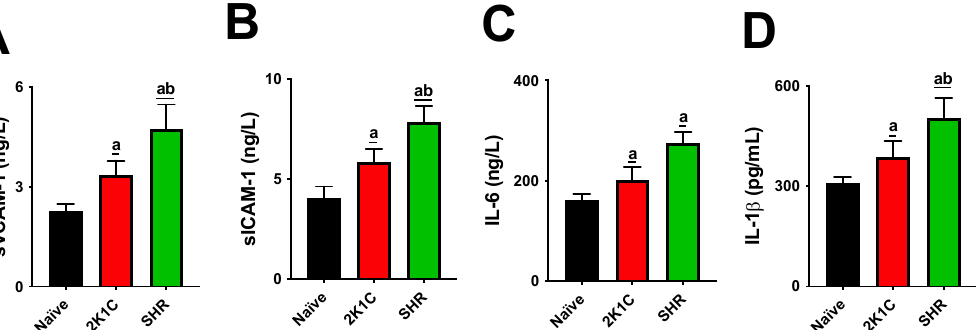
Figure 2. Serum interleukins and soluble adhesion molecule levels in normotensive and hypertensive high ‐ fat ‐ fed rats. Serum sVCAM ‐ 1 ( A ), sICAM ‐ 1 ( B ), IL ‐ 6 ( C ), and L ‐ 1 β ( D ) levels are shown. The data are expressed as mean ± standard error of the mean. a p ≤ 0.05 when compared with naive; b p ≤ 0.05 when compared with 2K1C group. 2K1C: two ‐ kidney ‐ one ‐ clip hypertension; IL ‐ 1 β : interleukin ‐ 1 β ; IL ‐ 6: interleukin ‐ 6; SHR: spontaneously hypertensive rats; sICAM ‐ 1: soluble intercellular adhesion molecule ‐ 1; sVCAM ‐ 1: soluble vascular cell adhesion molecule ‐ 1.